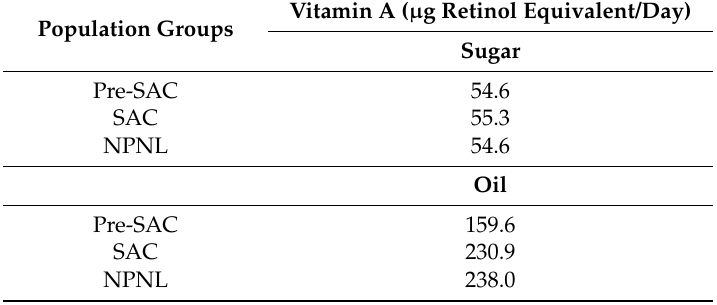
Table 6. Estimated daily contribution to vitamin A intake from fortified sugar and oil (using mean amounts consumed per day by each population group, and proposed fortification